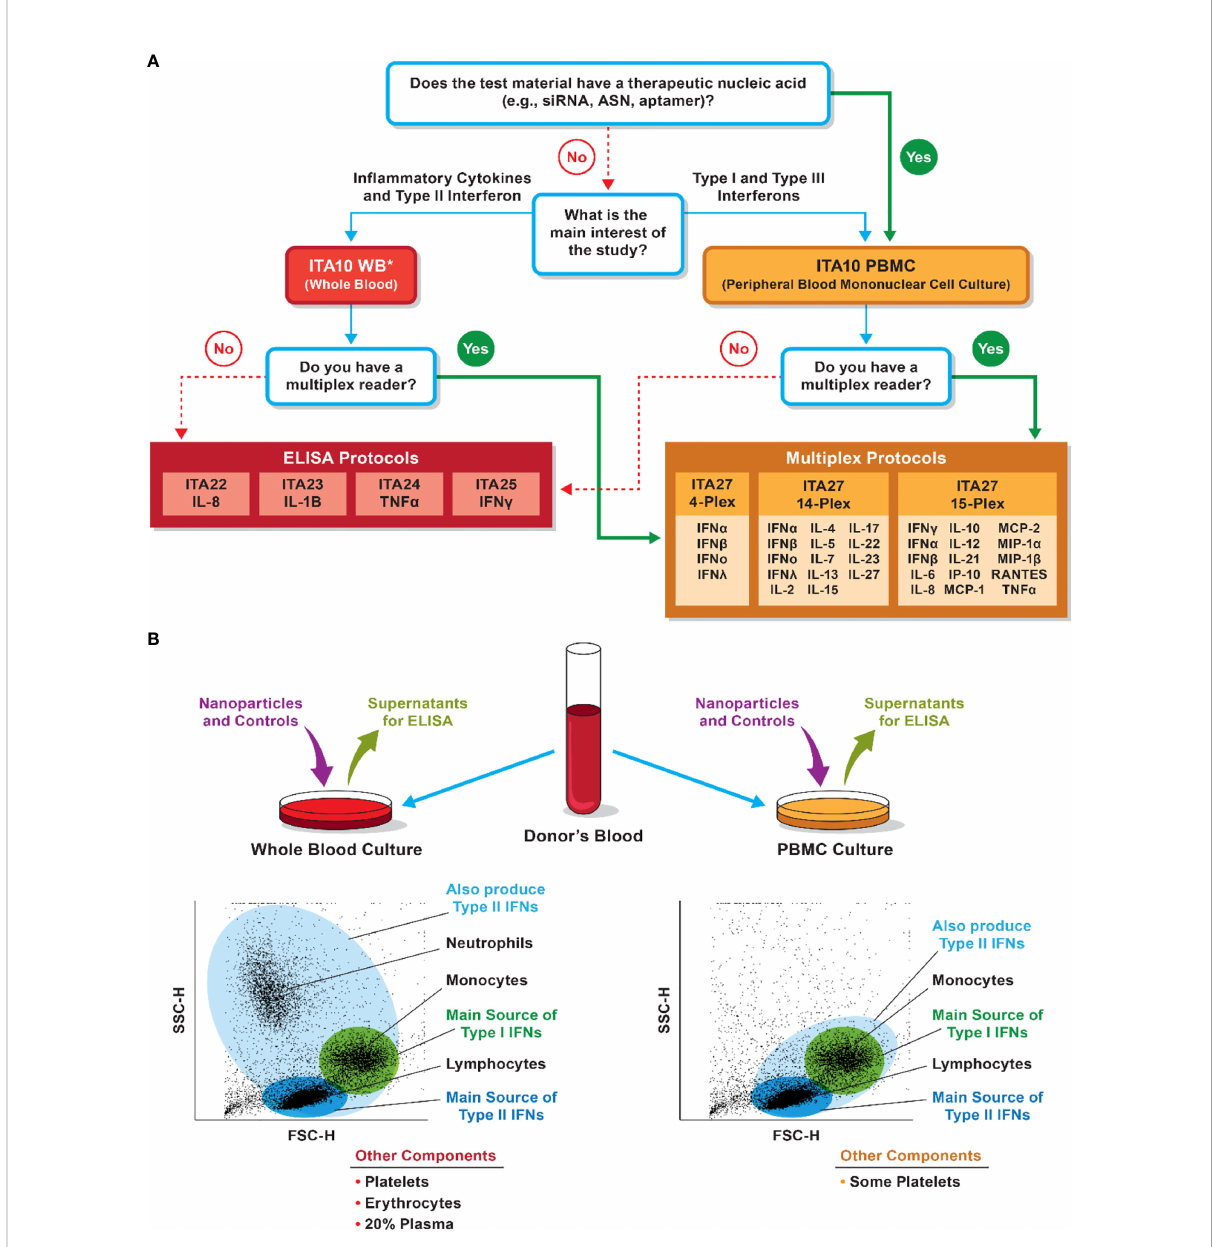
FIGURE 7 Considerations for selection of whole blood versus PBMC cultures for cytokine analysis. (A) NCL decision tree for model selection. The decision is in fl uenced by the nanoparticle composition, study questions, and instrument availability. *PBMC could be used to assess pro-in fl ammatory cytokines and answer questions related to the risk of the cytokine storm. Whole blood, however, is a better system if type II interferon induction is of interest. (B) Differences in immune-cell populations between the whole-blood and PBMC cultures may in fl uence the detection of various cytokines. Bullet points at the bottom list other cells or matrices present in the culture but not shown in the forward and side-scatter cytometry